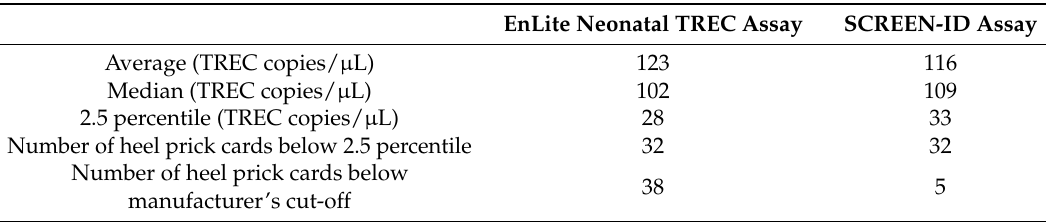
Table 1. Results of the analysis of 1272 fresh heel prick cards. The average, median and 2.5 percentile of both severe combined immunodeficiency (SCID) screening assays are depicted in copies/ μ L blood. The number of heel prick cards with T-cell receptor excision circle (TREC) levels below the 2.5 percentile and the number below the cut-off of the manufacturer are also shown.